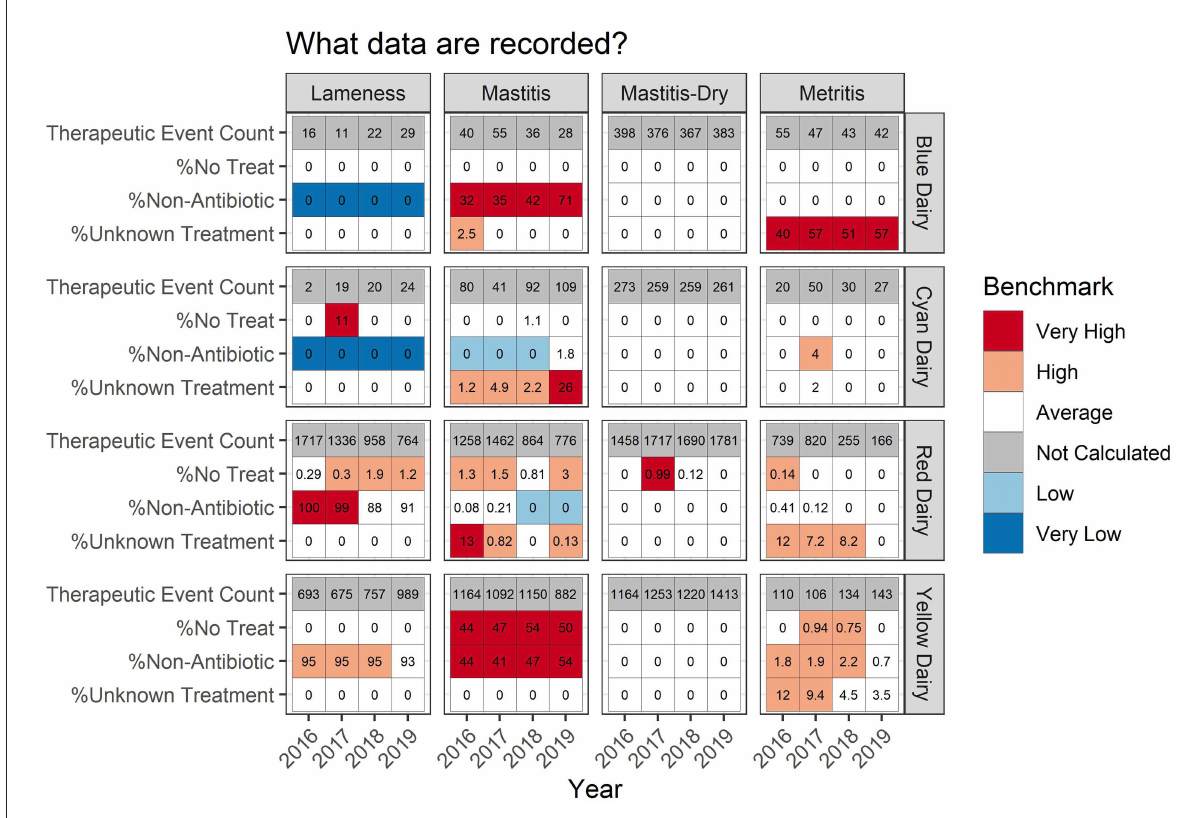
FIGURE6 For each measure listed on left the value is reported numerically within the cell. The background color indicates how that value ranks compared to other participating dairies. The measures listed in this table are not mutually exclusive and therefore do not sum to 100% within